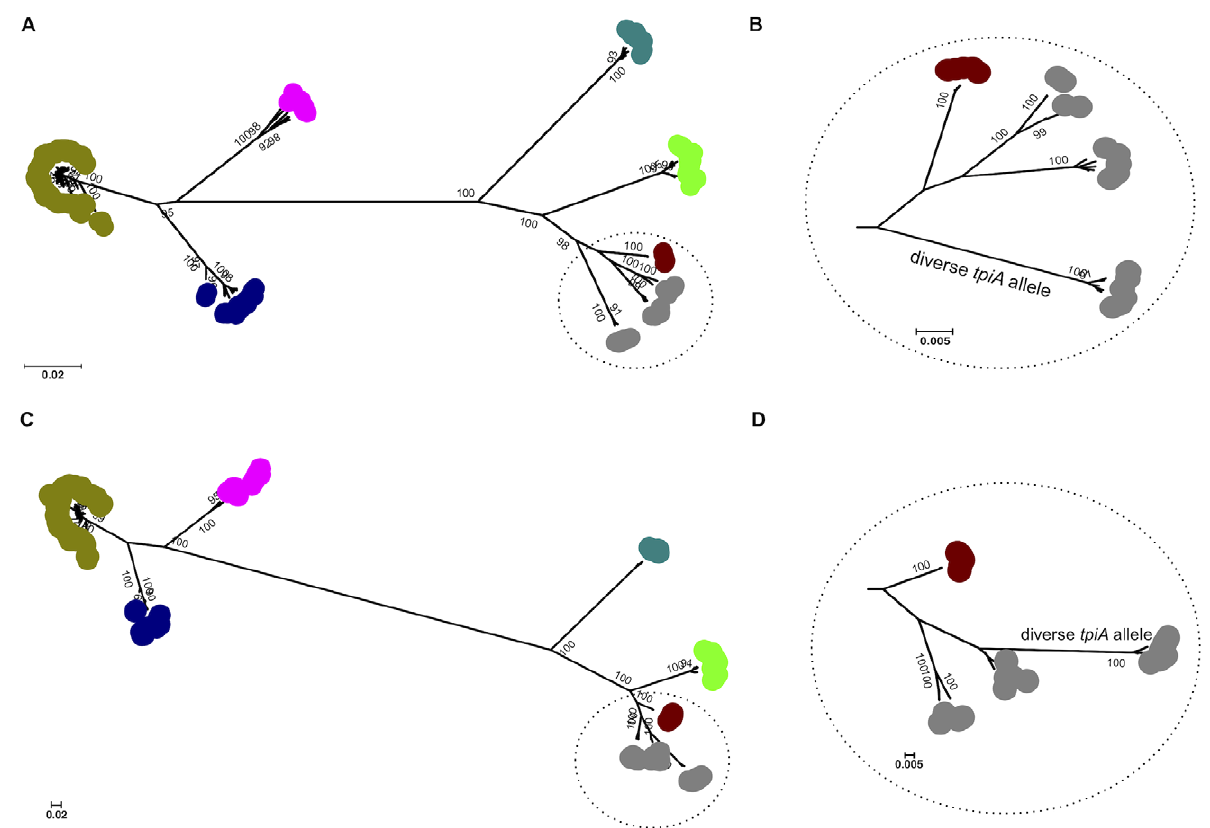
Figure 1. Phylogenetic trees based on concatenated sequences of 7 MLST loci. Phylogenetic trees were constructed based on concatenated sequences of 7 housekeeping loci for 189 unique STs using neighbor-joining (A) and maximum likelihood (C) methods. Both trees show six distinct clusters for 7 pathogenic Leptospira species. Relatedness between L. weilii isolates differ in the two trees; in the neighbor-joining tree, a cluster of L. weilii isolates with a highly diverse tpiA allele ( tpiA 51) was distantly related to other L. weilii isolates, as shown in the enlarged view (B). The maximum likelihood tree demonstrated that L. weilii isolates fell into three sub-groups that clustered together, as shown in the enlarged view (D). Color code: khaki, L. interrogans ; dark blue, L. kirschneri ; pink, L. nogouchii ; dark green, L. santarosai ; light green, L. borgpetersenii ; brown, L. alexanderi ; grey, L. weilli . Only bootstrap support values over 90% are shown.